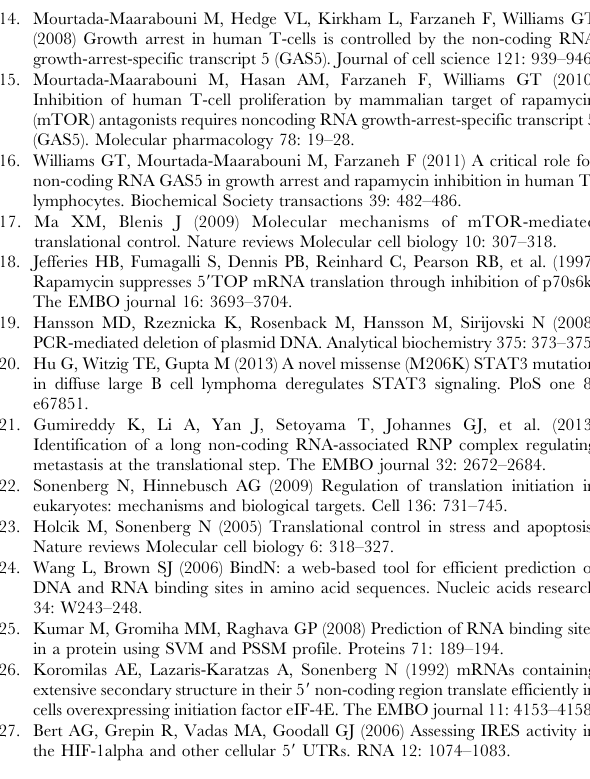
Figure S1 GAS5 interacts with translation initiation assembly. GAS5 mRNA was detected by RT-PCR after RNA-IP using eIF4G, eIF4A, eIF4E antibody and IgG. (TIF) Figure S2 The effect of the deletion of motif-1 and motif- 2 on the stability of eIF4E protein. (A) The protein level of eIF4E and its deletion mutants tagged with HA was assessed by western blot. (B) The protein level of eIF4E and its deletion mutants tagged with HA was assessed by western blot after the cells were treated with 100 m g/ml CHX for 0, 2, 4, 6, 8 and 24 hours.